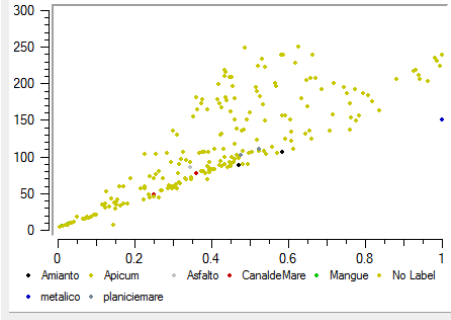
Figure 7: Exploratory analysis by samples.